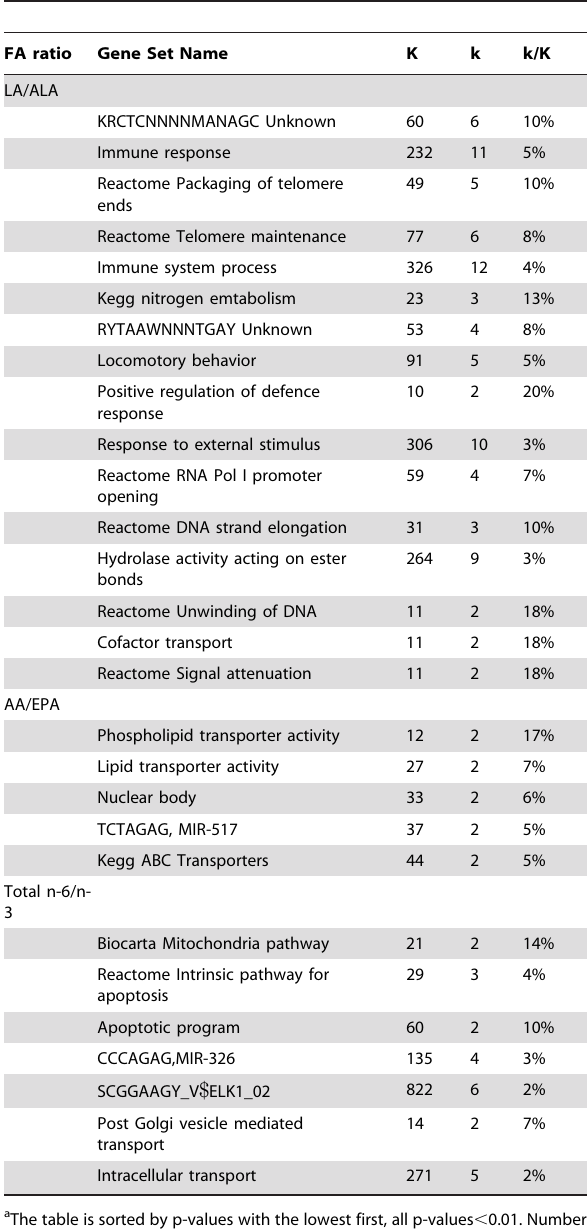
Table 7. Significant overlaps between differentially expressed genes and reported gene sets in MSigDB a .